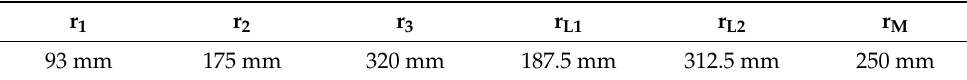
Figure 2. ( a ) Three-dimensional geometry model of the investigated disc brake system, ( b ) simplified finite element model of the brake disc, ( c ) description of brake disc dimension. Table 1. Geometry dimension of brake disc.